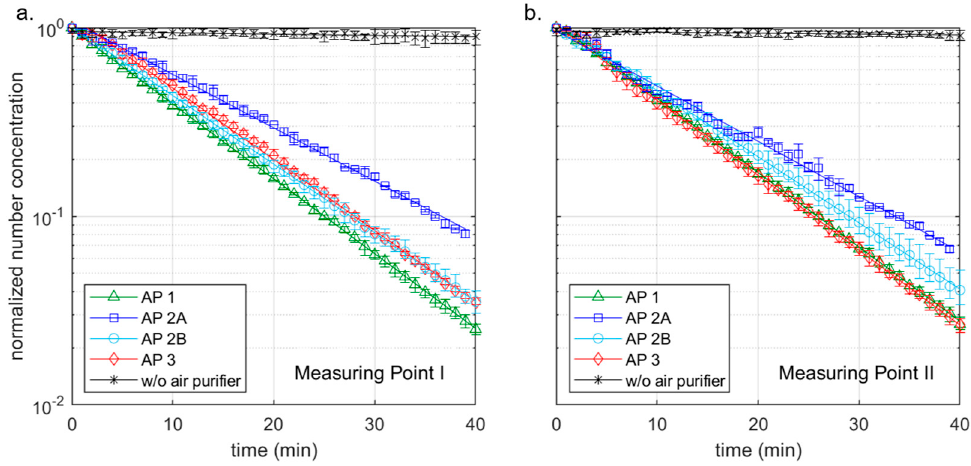
Figure 3. Normalized aerosol number concentration of three different APs at an air exchange rate of around 5.4 h − 1 , as well as without AP at two different measuring points MP I ( a ) and MP II ( b ). AP 2 has been tested at two different positions, on the short side of the room (A) and on the long side of the room